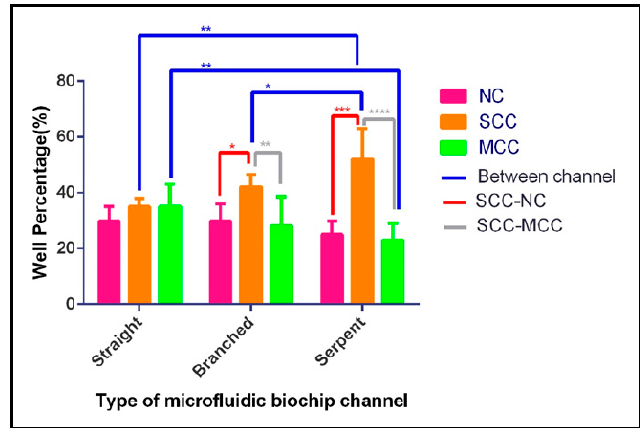
Figure 10. Cell trapping capabilities of three channel designs with the comparison of NC, SCC, and MCC based on the study conducted. Mean and SD were plotted from five independent repeated experiments. ANNOVA analysis was done within each design to find the significant parameters and two-way ANNOVA analysis was done comparing the designs to find the significant parameters. It can be seen that in the serpent design NC and MCC are the least, and SCC is the maximum in comparison to the others.